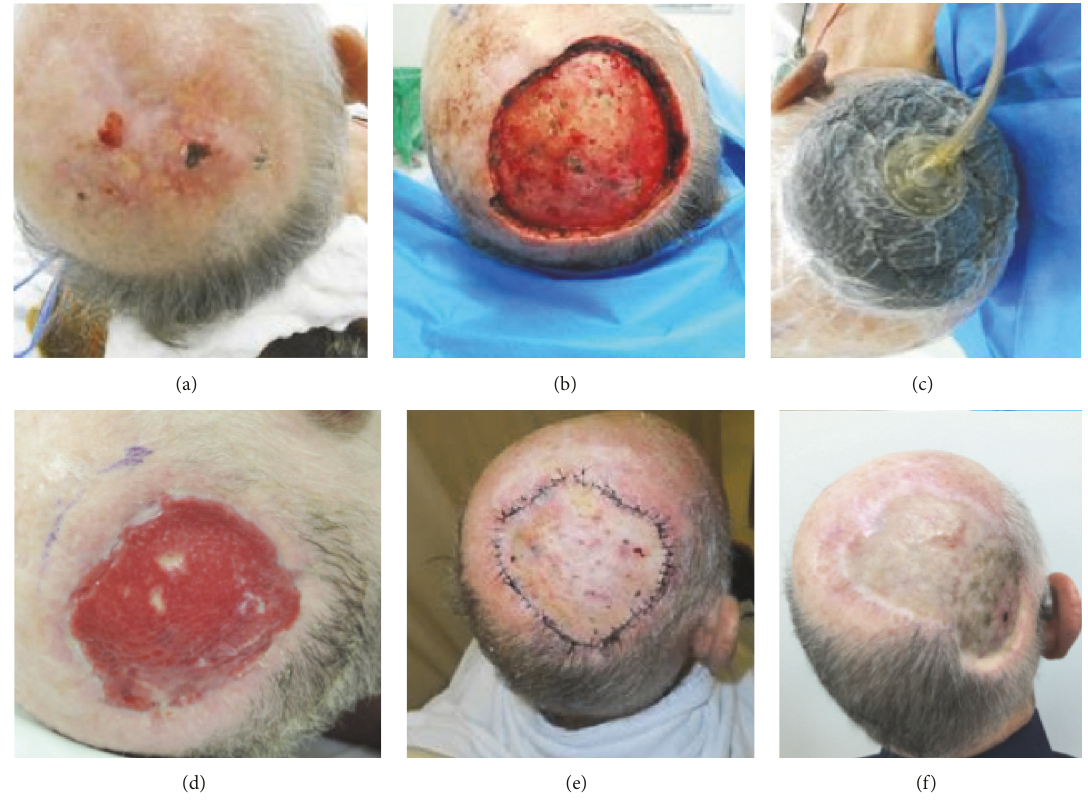
Figure 1: (a) Basal cell carcinoma in scalp, clinical aspect before surgery; (b) surgical bed with periosteal removal; (c) negative pressure wound therapy was applied after Matriderm to enhance granulation; (d) granulation tissue; (e) skin graft, early postoperative aspect; (f) late postoperative